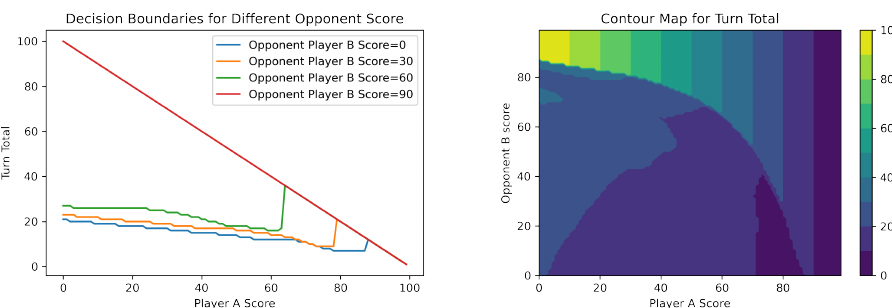
Figure 4. Left: Comparison between different boundary curves for Player A who goes first when the opponent Player B’s score changes. Right: contour for the turn total given Player A’s score and the opponent Player B’s score.